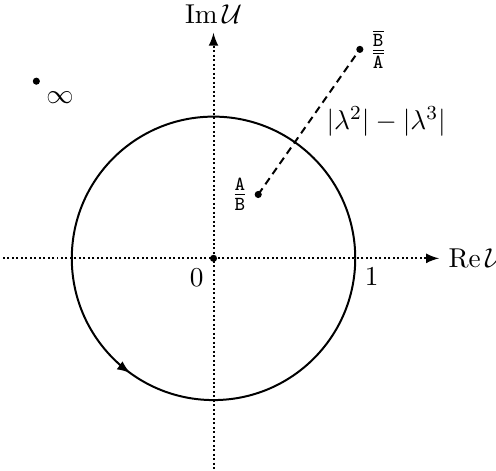
Figure 2 . Sample pole con(cid:12)guration of the integrand in (4.12) for the undeformed u (1 ; 1) Yangian invariant (cid:9) 4 ; 2 . A pair of poles is connected by a dashed line. The sign of the variable j (cid:21) 2 j (cid:0) j (cid:21) 3 j controls which of the poles lies inside of the